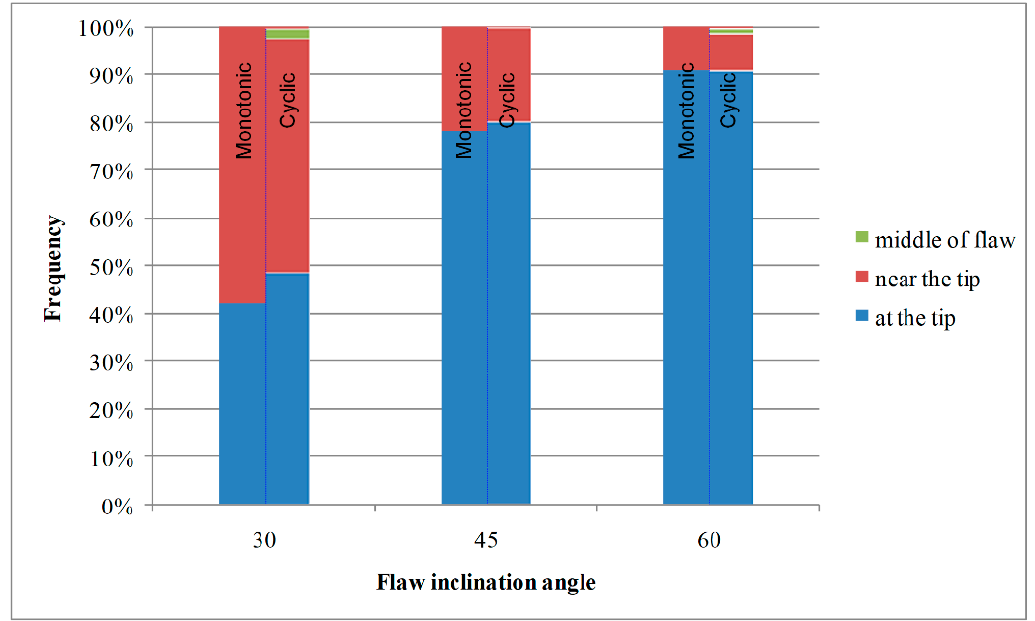
Figure 6. Wing crack initiation position.